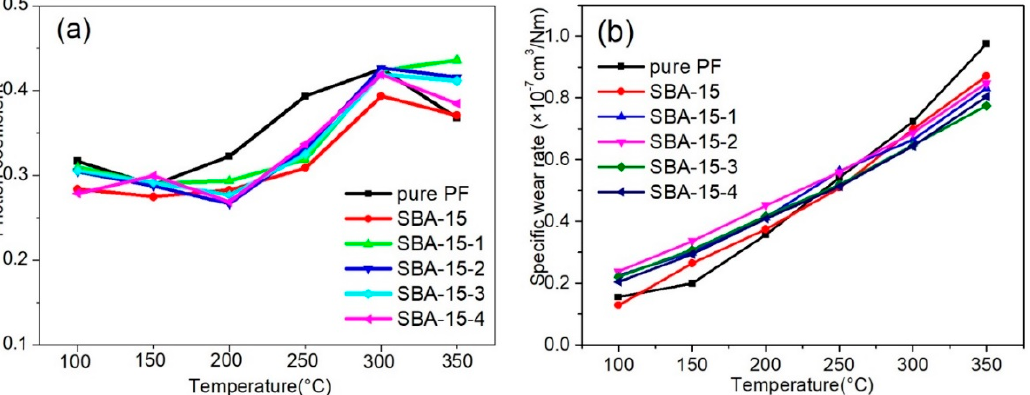
Figure 9. Friction curves of the friction coefficient ( a ) and volume wear rate ( b ) for the SBA-15/PF nanocomposites.